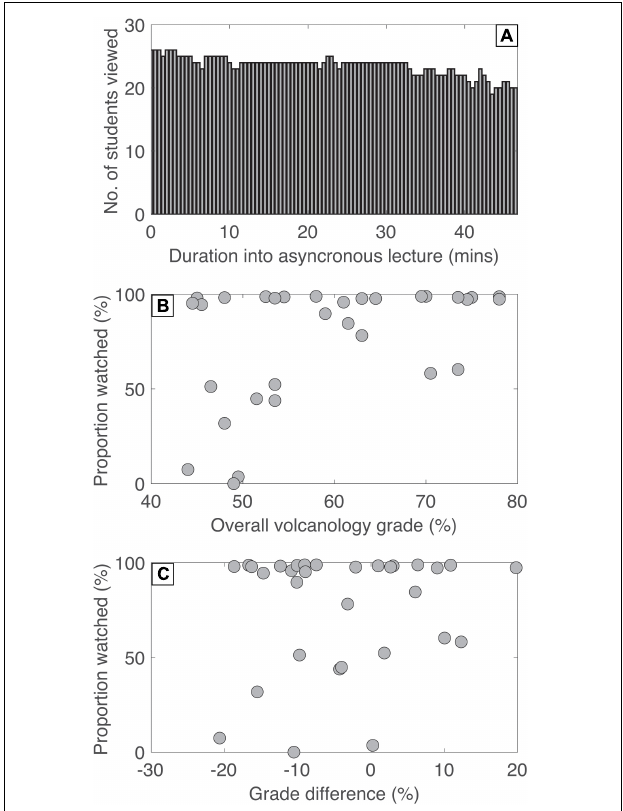
FIGURE 5 | Viewing statistics of the embedded lecture videos. (A) The number of students that viewed each half minute segment of Lecture 1.2 at least once. Note that only one lecture (Lecture 1.2) is shown for illustrative purposes, but this analysis was performed on all asynchronous lecture videos. (B,C) The proportion of all asynchronous lecture videos that were watched at least once compared to: (B) the overall grade obtained by each student; (C) the grade difference between the average grade obtained in the first 2 years of university study and the overall volcanology grade. A positive grade difference indicates that the student did better in the volcanology course relative to their university